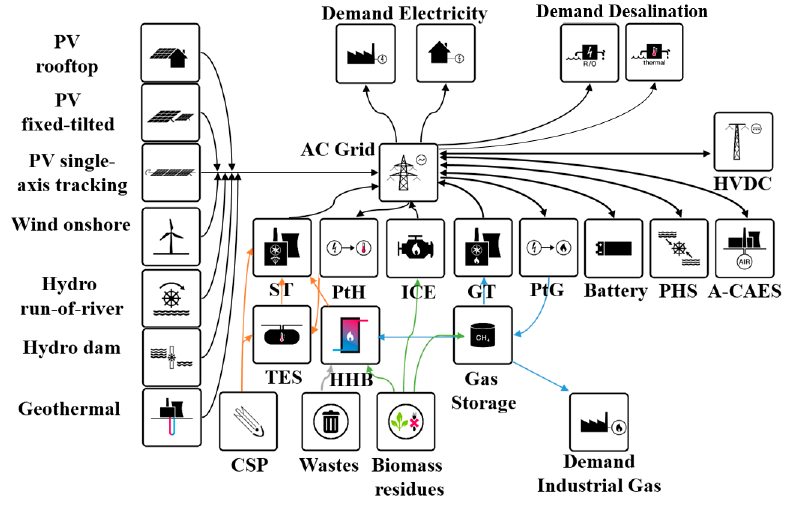
Figure 2. Block diagram of the LUT Energy Systems model used for Saudi Arabia.